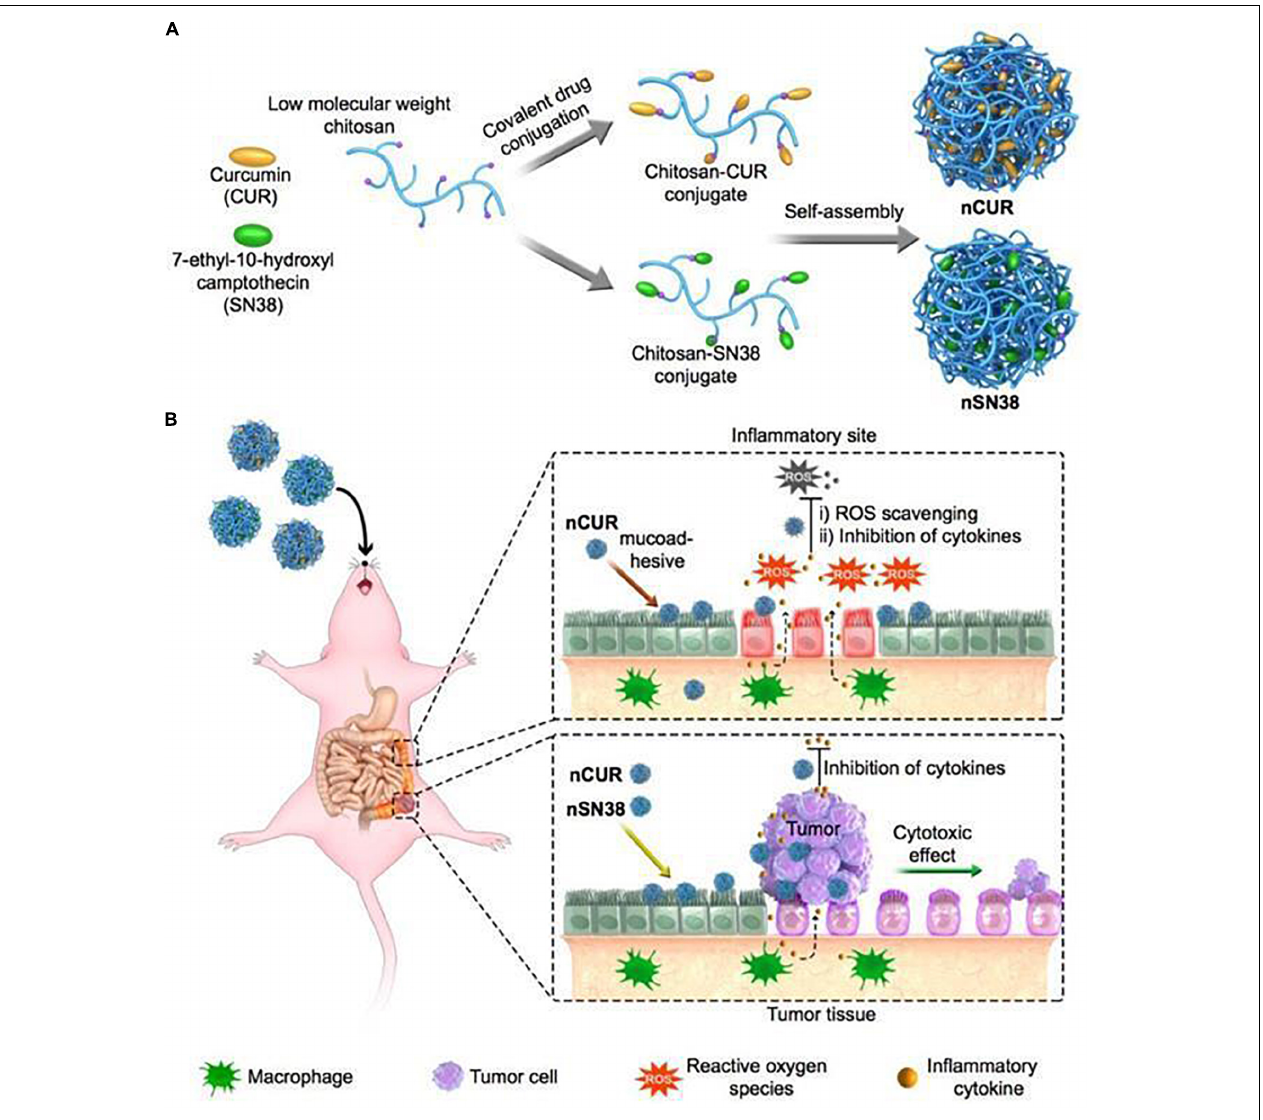
FIGURE 5 | A scheme of self-assembly of chitosan-drug conjugates to form NPs and their oral administration for CAC treatment (Han et al., 2019). (A) Curcumin and SN38 were individually tethered to carboxylated chitosan by a self-hydrolyzable ester linkage. This formed amphiphile construct could be self-assembled in aqueous media and was suitable for oral administration. (B) Using a preclinical CAC mouse model, the anti-inflammatory nCUR and cytotoxic nSN38 nanoparticles could accumulate and release drugs in inflamed intestinal tissues and tumor tissues after oral administration, acting as an inhibitor of inflammation and tumor